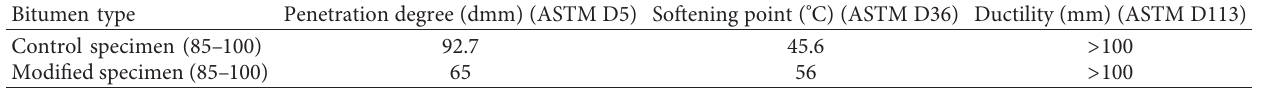
Table 2: Bitumen characteristics.